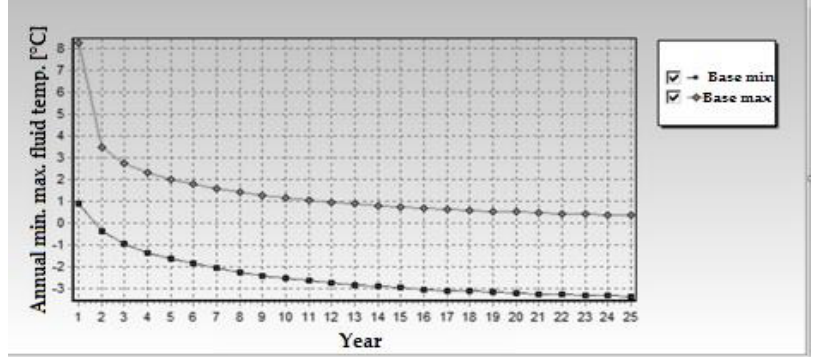
Figure 11. Temperature progression over 25 years under Scenario 4 (calculated by [16]).